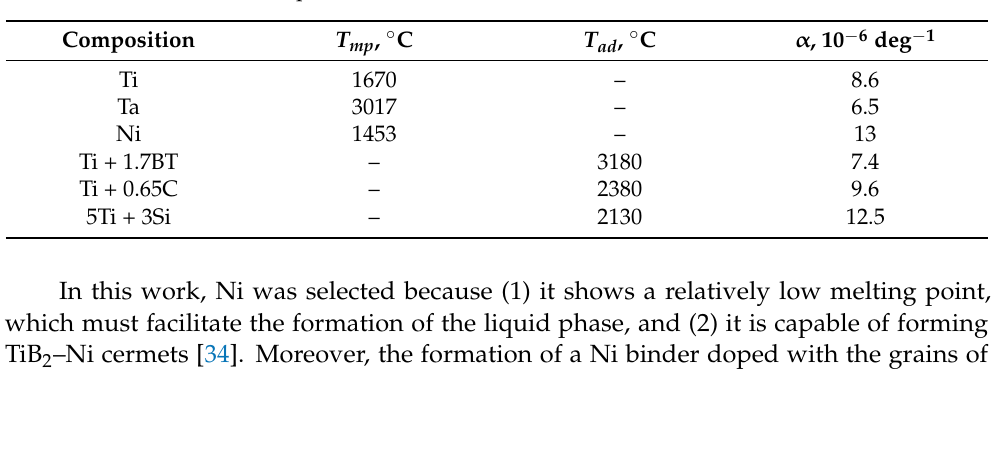
Table 1. Melting points T mp for foil metals, adiabatic combustion temperature T ad for reactive tapes, and coefficients of thermal expansion α for all constituent